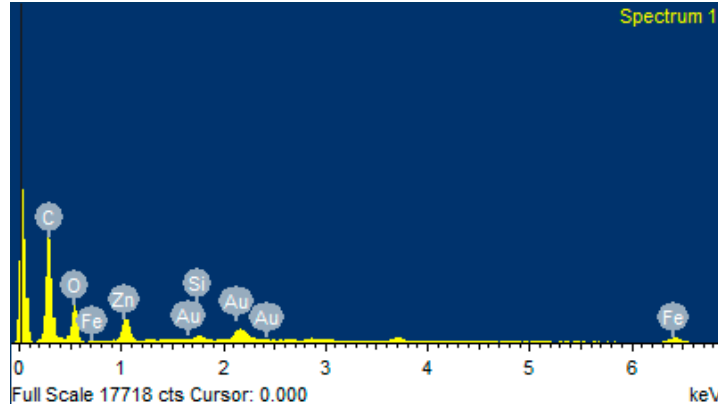
Figure 4. EDX of ZnO functionalized hydrogel grafted silk dressing.